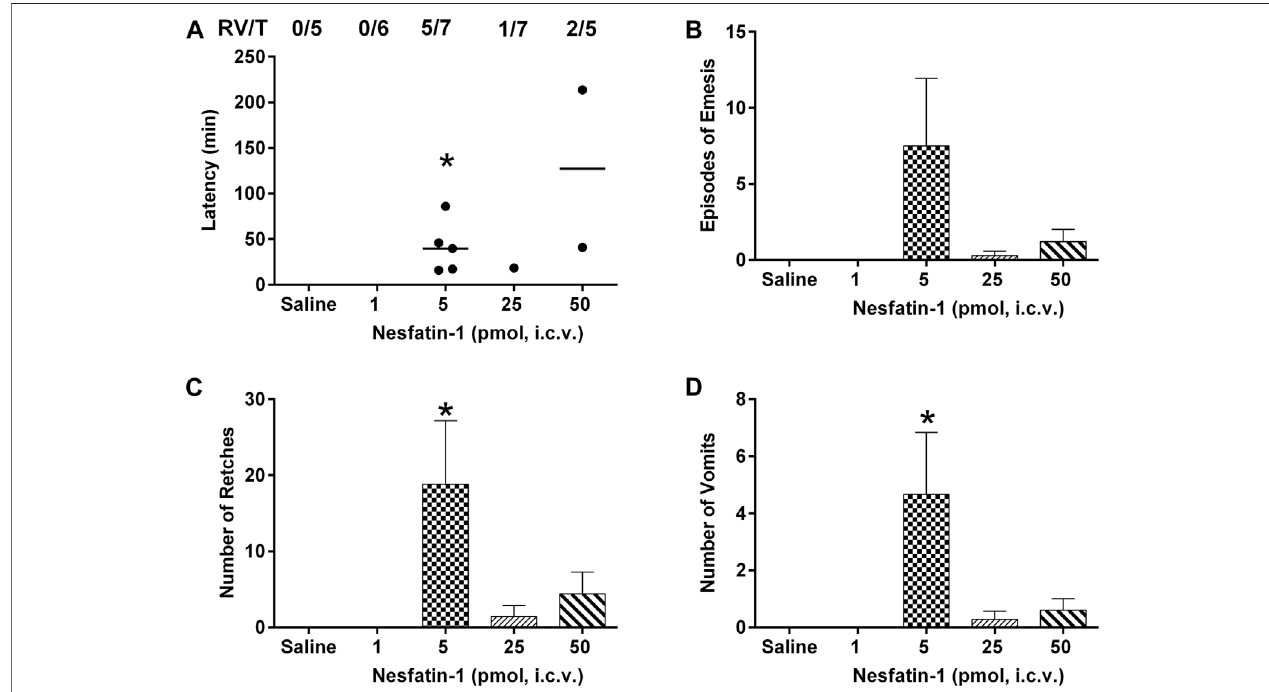
FIGURE5| Effectsofintracerebraldrugadministrationonemesisin Suncusmurinus . (A) Latencytoemesis, (B) episodesofemesis, (C) numberofretchesand (D) numberofvomitsafterani.c.v.administrationofsaline(5 μ l,i.c.v.)ornesfatin-1(1 – 50 pmol,i.c.v).Theresultsrepresentthemean±s.e.m.of5 – 7determinationsduringa period of6 h.Thenumberofanimalsretchingand/orvomitingoutofthenumberofanimalstested (RV/T)isindicatedasafractionofeachtreatment group.Latencydata areshownasindividualresponses, withlinesindicatingthemedianresponsetime.Signi fi cantdifferencesbetweenthetreatment groupsareindicatedas p p < 0.05 (one-way ANOVA followed by Bonferroni